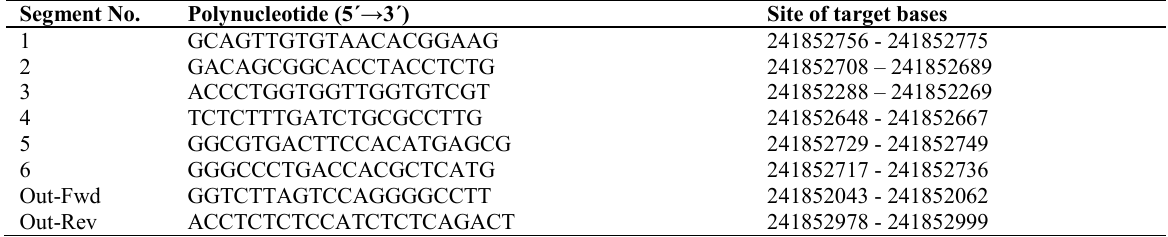
Table 1. Polynucleotides and target locations on the PD-1 gene. Segment